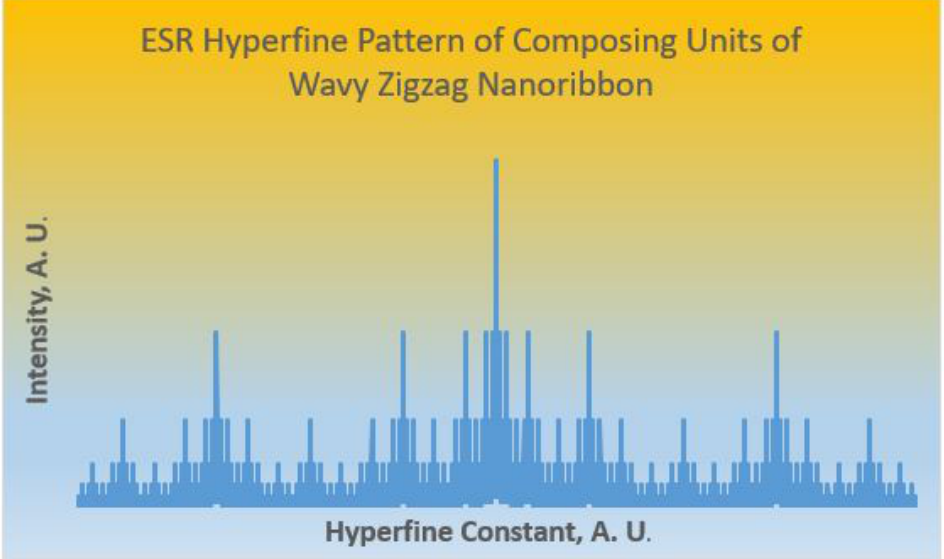
Figure 6. ESR hyperfine pattern arising from the composing units of wavy zigzag nanoribbon